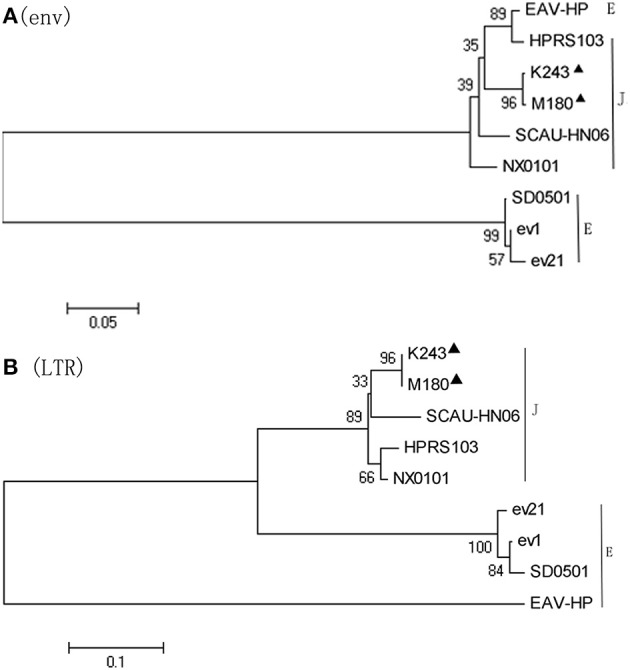
Phylogenetic analysis based on the env and LTR sequences. Phylogenetic relationship of the two novel ALV-J isolates to reference ALV strains and endogenous virus sequences. Black triangles indicate isolates M180 and K243 in this study. (A) Phylogenetic analysis of the env sequence. (B) Phylogenetic analysis of the LTR sequence.